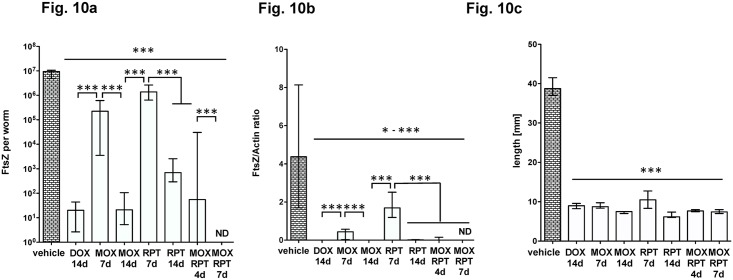
Lower dose MOX in a RPT/MOX double-combination is effective.Antibiotics were administered ip at 50 mg/kg, RPT at 15mg/kg and MOX 100 mg/kg ip/d. Worms were recovered at day 35 post infection. FtsZ copy numbers (a) and the FtsZ/Actin ratio (b) are given per single female worm DNA extract. The female worm length is shown in (c,). Significances were tested with MW-U test, a p-value of 0.05 was considered significant and exact p-values are given in S1 Table.